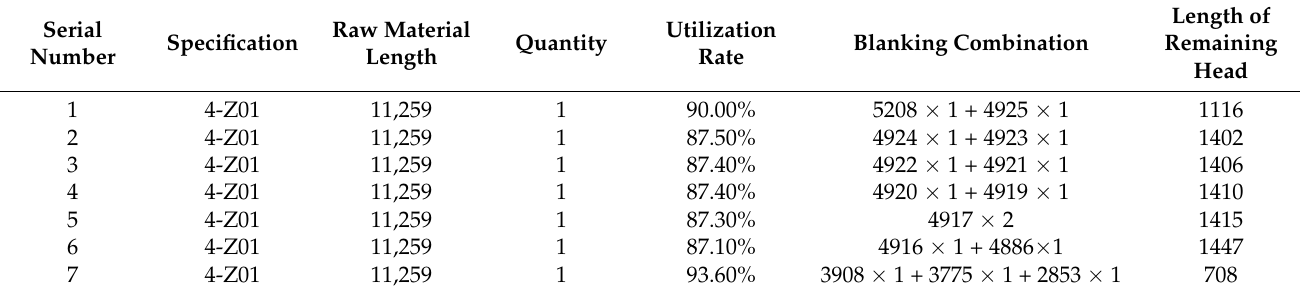
Table 9. 4-Z01 keel blanking combination.